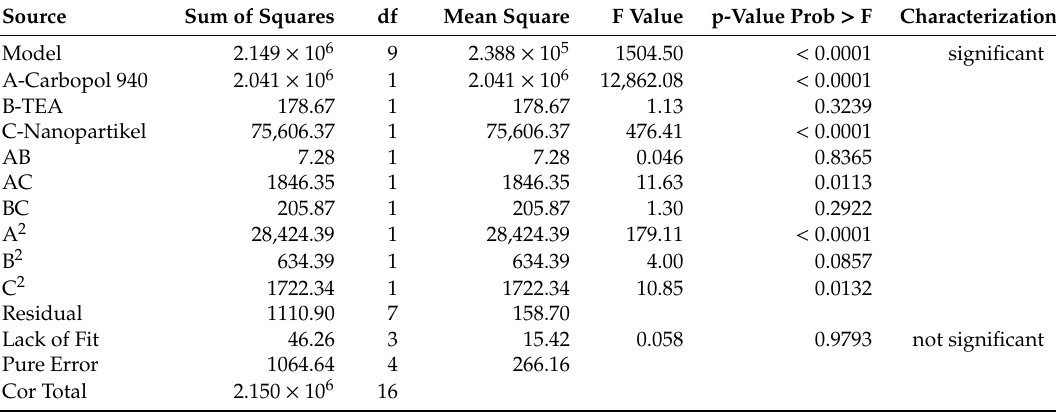
Table 6. ANOVA analysis of quadratic model for the viscosity of the arabica co ff ee ground nanoparticles gel